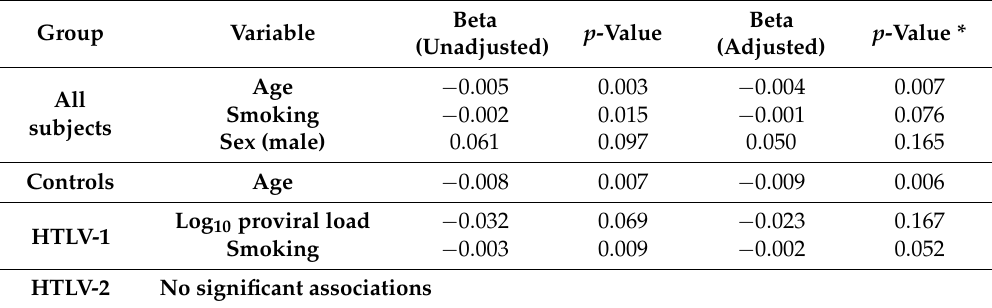
Figure 1. Telomere length by human T ‐ cell lymphotropic virus (HTLV) infection status. Telomere ‐ to ‐ single ‐ copy gene (T/S) ratio measured by quantitative PCR (qPCR) for 45 seronegative donor controls, 45 HTLV ‐ 1 positive patients and 45 HTLV ‐ 2 positive patients. Boxes show median and IQR, whiskers depict additional range, except for values > 1.5 × IQR from median, which are shown as circles. Mean T/S ratio (1.02 ± 0.16 in HTLV ‐ 1, 1.03 ± 0.17 in HTLV ‐ 2 and 0.99 ± 0.18 in HTLV seronegative subjects) did not differ significantly; comparing either HTLV ‐ 1 or HTLV ‐ 2 cases to controls, or combined HTLV cases to controls ( p = 0.322). Table 2. Variables associated with log e (telomere-to-single-copy gene (T/S)